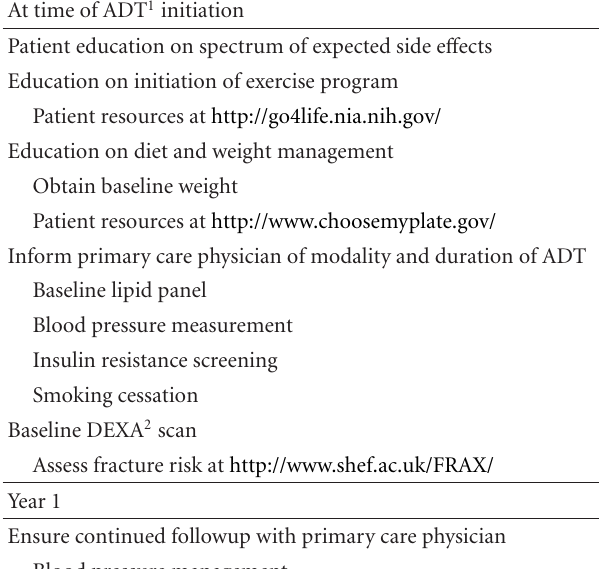
Table 1: Suggested management for patients receiving androgen deprivation